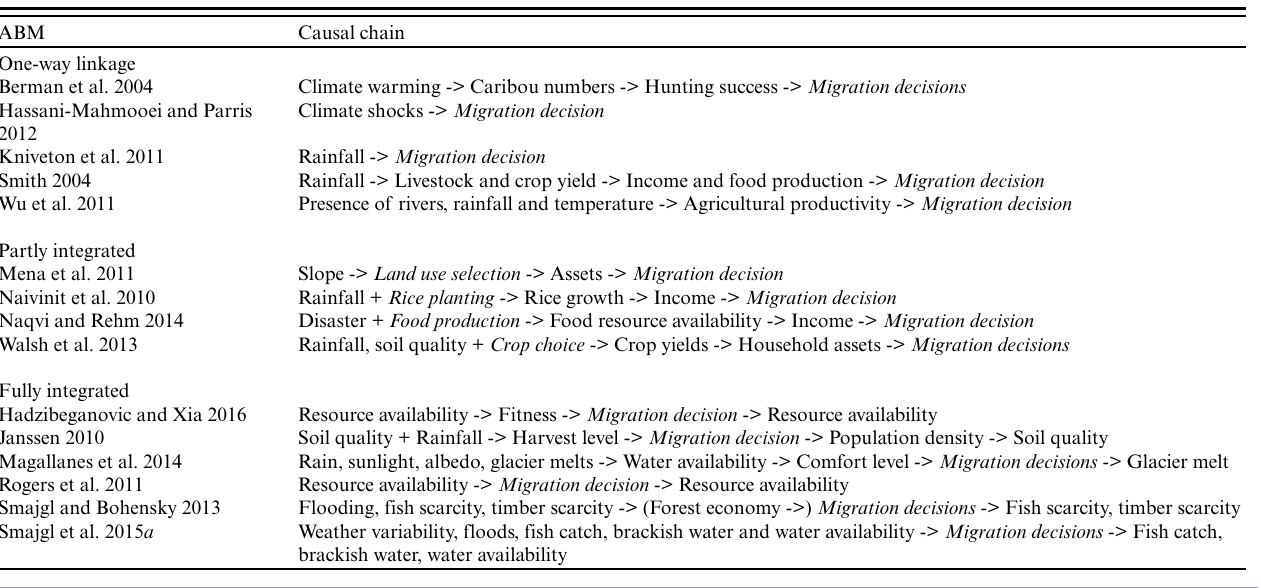
Table 5 . Causal chains representing the social-ecological feedbacks within the reviewed agent-based models (ABM); italic terms represent actions taken by the agents; the term in brackets applies only for parts of the causal chain, i.e., forest economy is affected by timber scarcity. ABM Causal chain One-way linkage Berman et al.